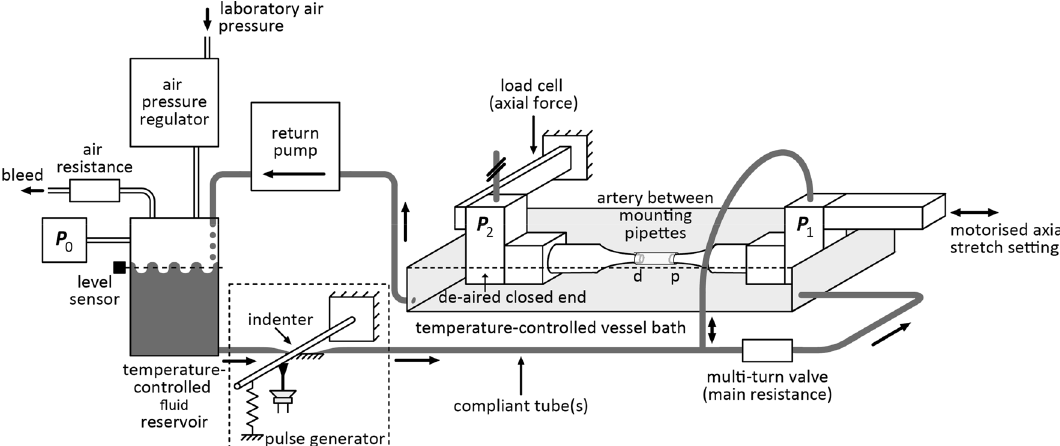
Figure 1. Set-up specialised for biaxial biomechanical assessment of murine arteries under pulsatile conditions. p and d, proximal and distal pipettes for mounting the artery. P 0 , P 1 , and P 2 are sensors registering reservoir and proximal and distal pipette pressures, respectively. Note that sensor P 2 is at a de-aired closed end. For detailed description, see main